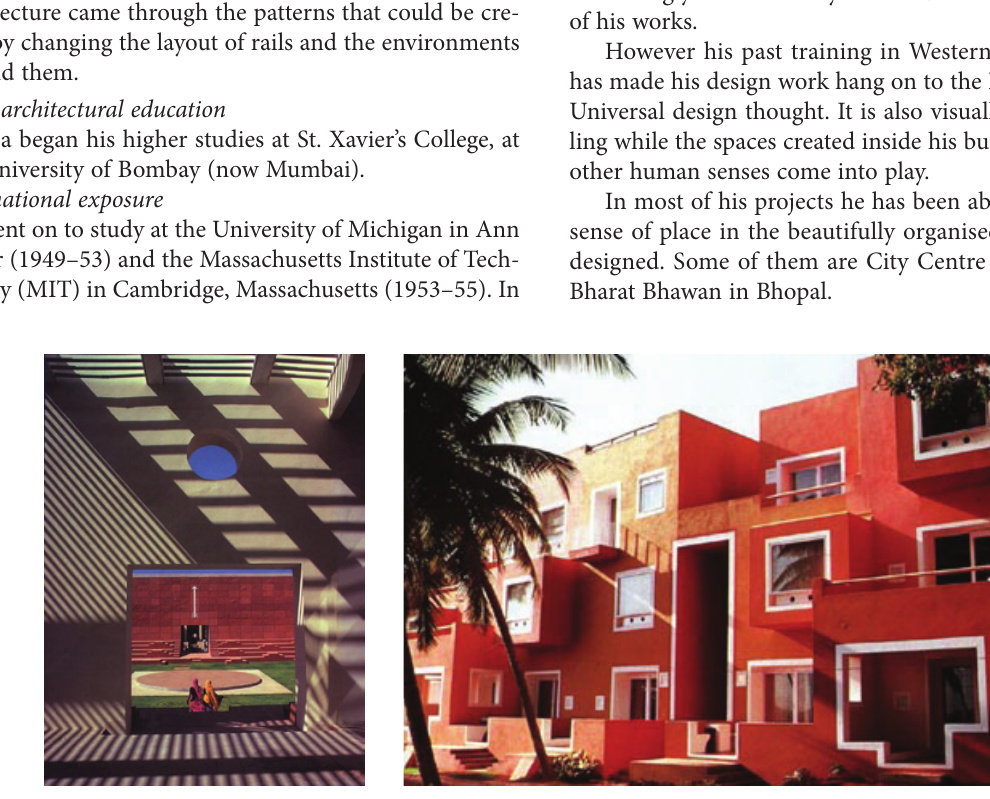
Figure 4. Jawahar Kala